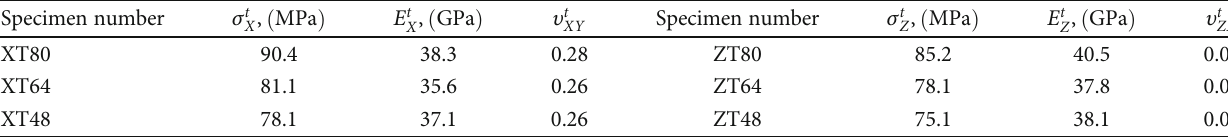
Table 4: Tensile mechanical properties of axial braided C/C composites.